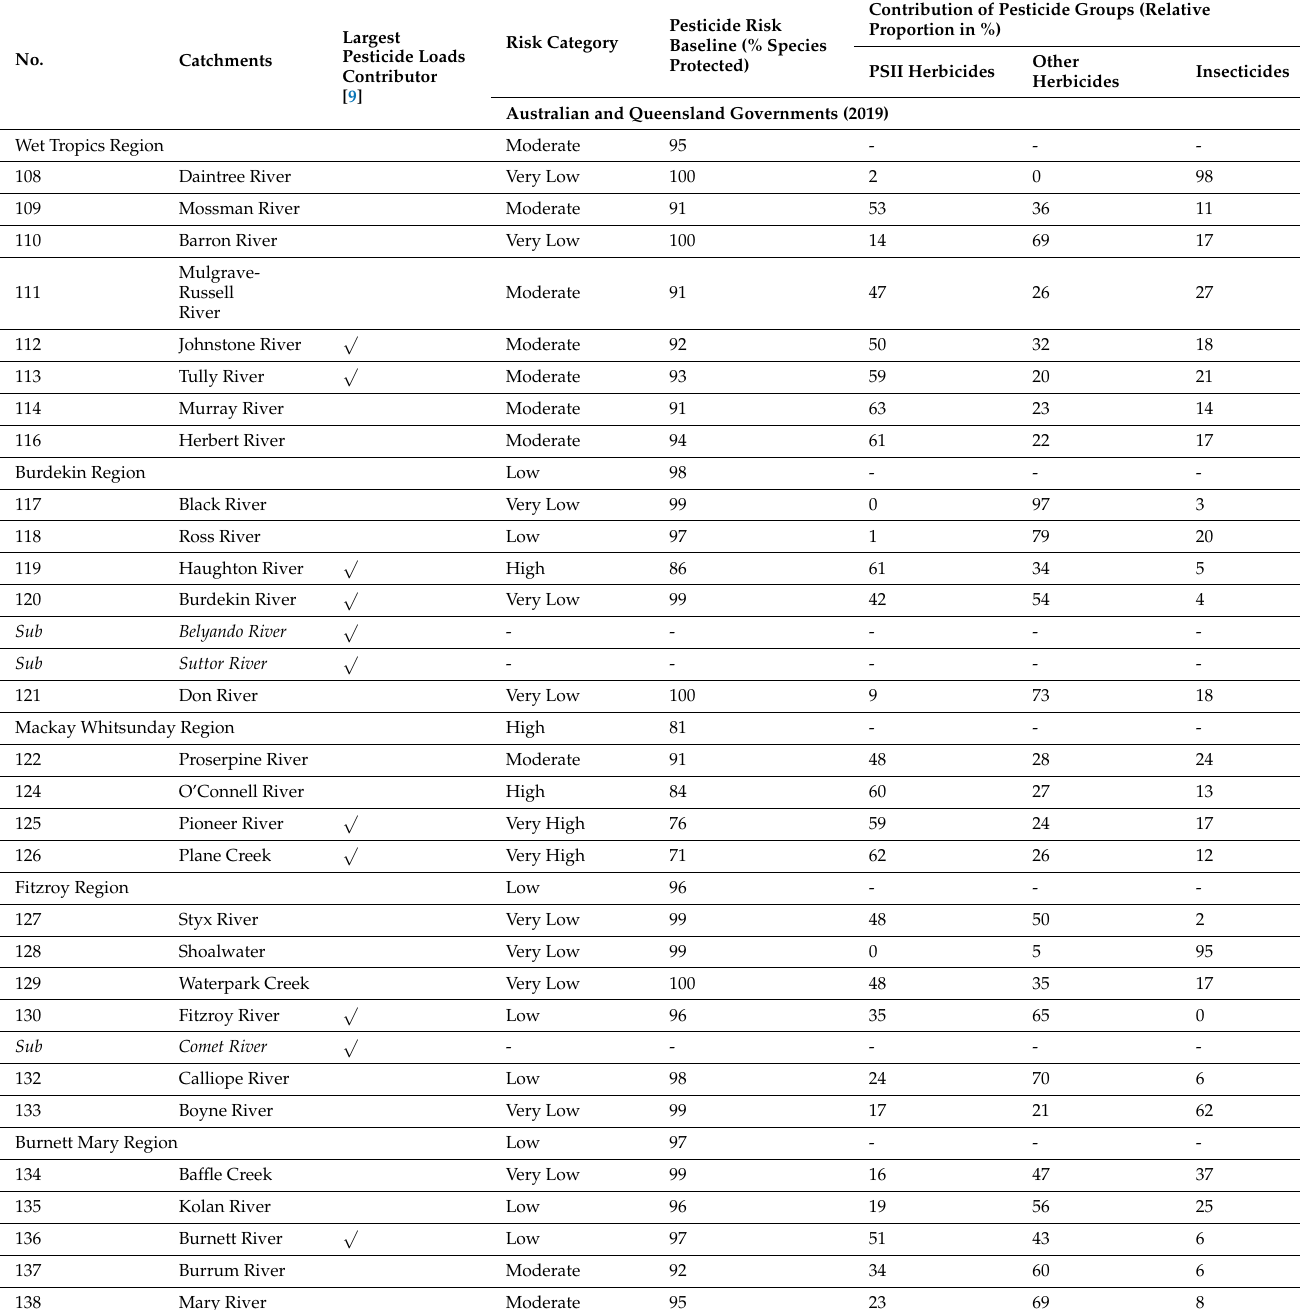
Table 2. Pesticide risk of the GBR